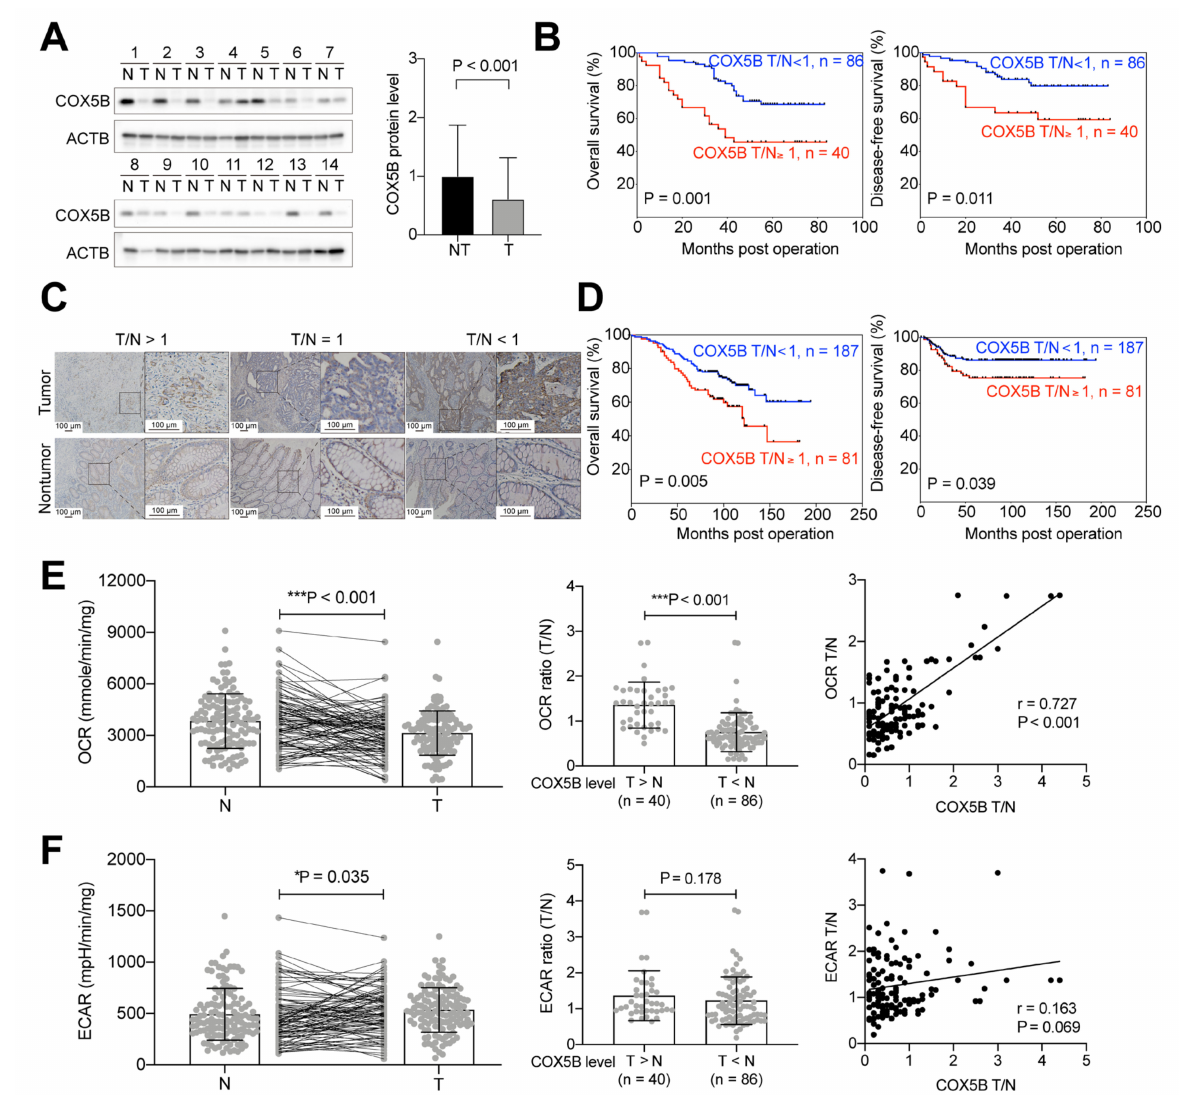
Figure 1. Increased COX5B is associated with unfavorable prognosis and elevated OCR in CRCs. ( A ) The representative images of Western blot analysis of lysates from both nontumorous (N or NT) and tumorous (T) tissues. COX5B, Cytochrome c Oxidase subunit 5B; ACTB, Actin Beta. The quantification results were shown in the right panel, analyzed by two-tailed paired Student’s t -test. ( B ) Kaplan–Meyer analysis of survival rates of subgroups of patients employed in ( A ). The subgroups of patients were separated according to the COX5B T/N ratio ≥ 1 or < 1 obtained from the Western blot analysis. ( C ) The representative images showing the IHC staining of COX5B on tissue slide sections. ( D ) Kaplan–Meyer analysis of survival rates of subgroups of patients employed in ( C ). The subgroups of patients were separated according to the COX5B T/N ratio ≥ 1 or < 1 obtained from the staining intensities of IHC. ( E , F ) The OCR and ECAR in either non-tumorous (N or NT) or CRCs tumorous (T) tissues. The p values in the left panels were acquired by two-tailed paired Student’s t -test, while two-tailed unpaired Student’s t -test was used for the middle panel. *, p < 0.05; ***, p < 0.001. Pearson correlation analysis was employed for the right